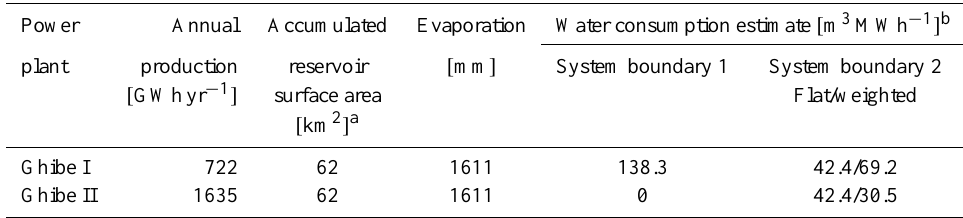
Table 3. Characteristics and water consumption estimates for Ghibe I and II. The power production data are average production values for a non-specified period. Primary source: Yesuf